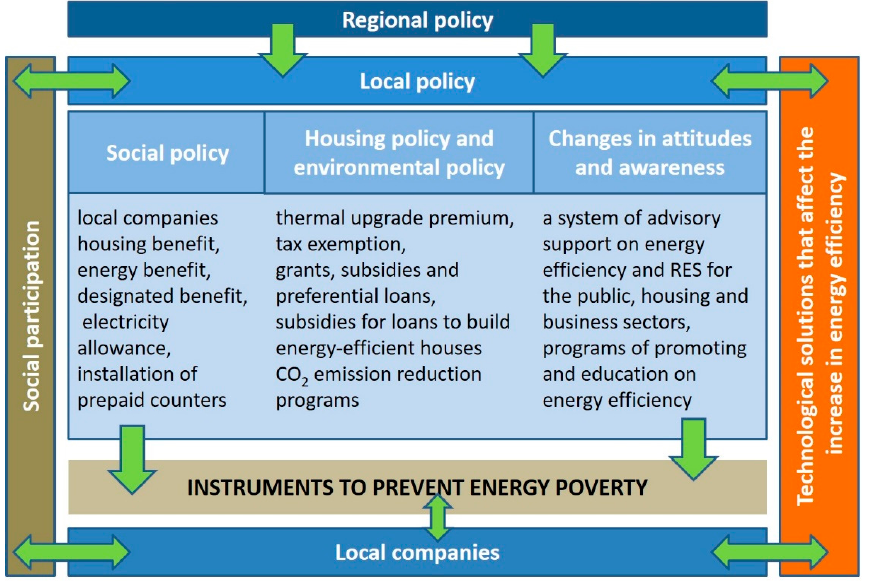
Figure 2. A local policy model, based on social, economic, and technical data to improve the energy efficiency of buildings. efficiency of